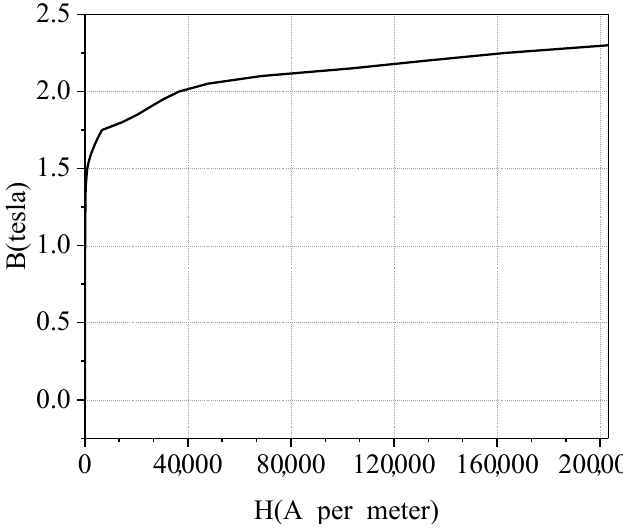
Figure 9. Silicon steel sheet B–H curve.